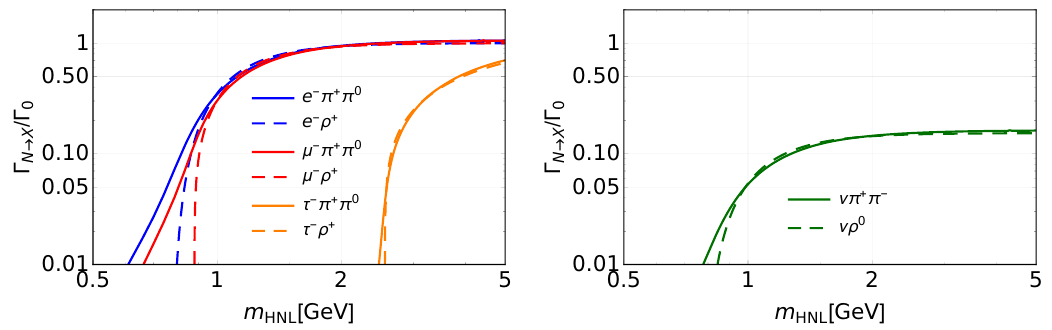
Figure 15 . Left panel: decay widths of charged current channels with (cid:26) or 2 (cid:25) divided by (cid:0) 0 = g 2 (cid:26) 1 2 2 M 3 G 2 V ud U (cid:11) , which is prefactor in eq. (3.8). Right panel: the same for neutral current F N 16 (cid:25) m 2 (cid:26) j j j j